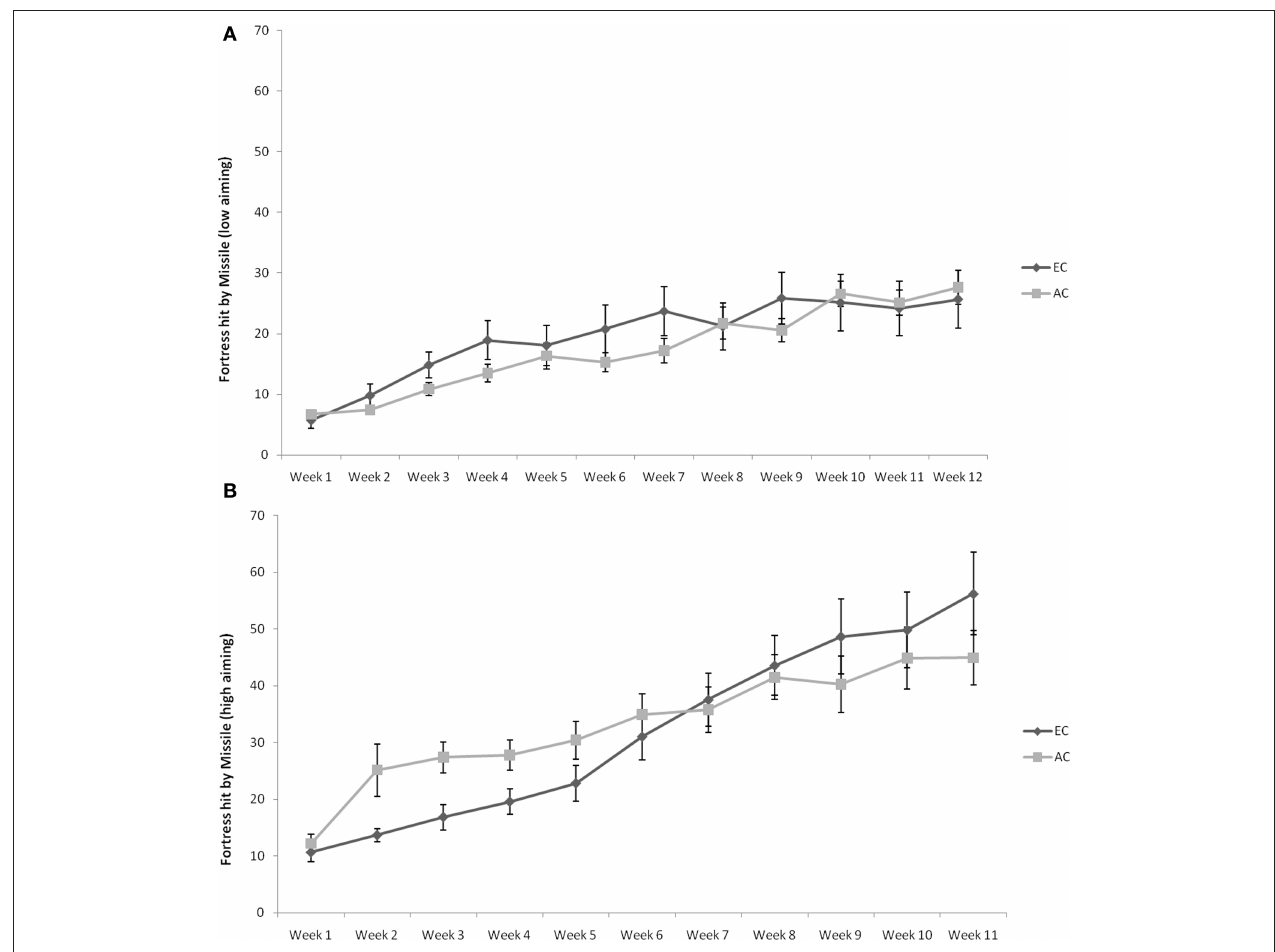
FiGurE 4 | (A) Fortress hit by Missile as a function of training instructions (EC vs. Standard) in participants with low ( < 450) subject-specific aiming scores. (b) Fortress hit by Missile as a function of training instructions (EC vs. Standard) in participants with high ( > 450) subject-specific aiming